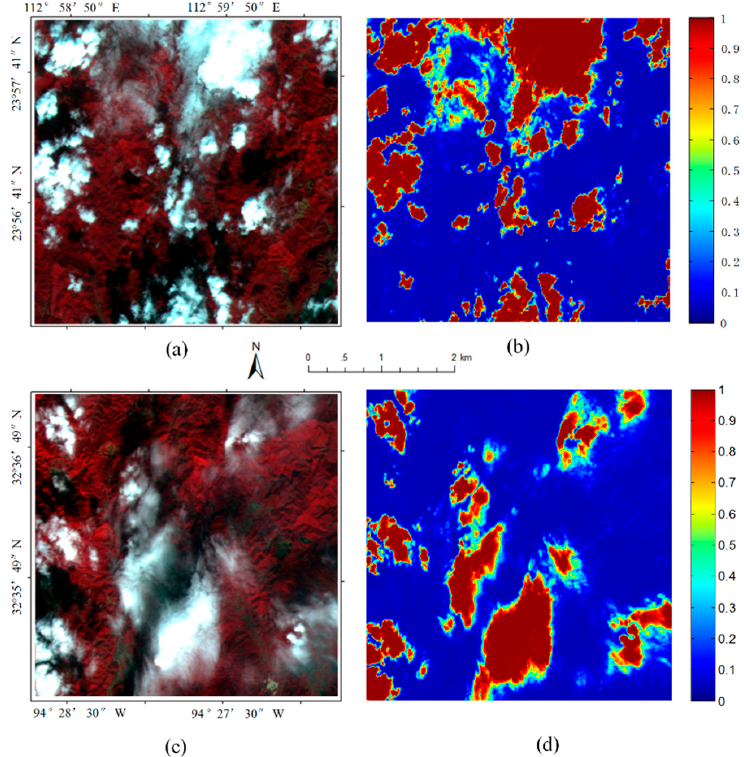
Figure 7. ( a , c ) The original image of GF-1 images; and ( b , d ) the corresponding cloud density of ( a , c ) with proposed approach.